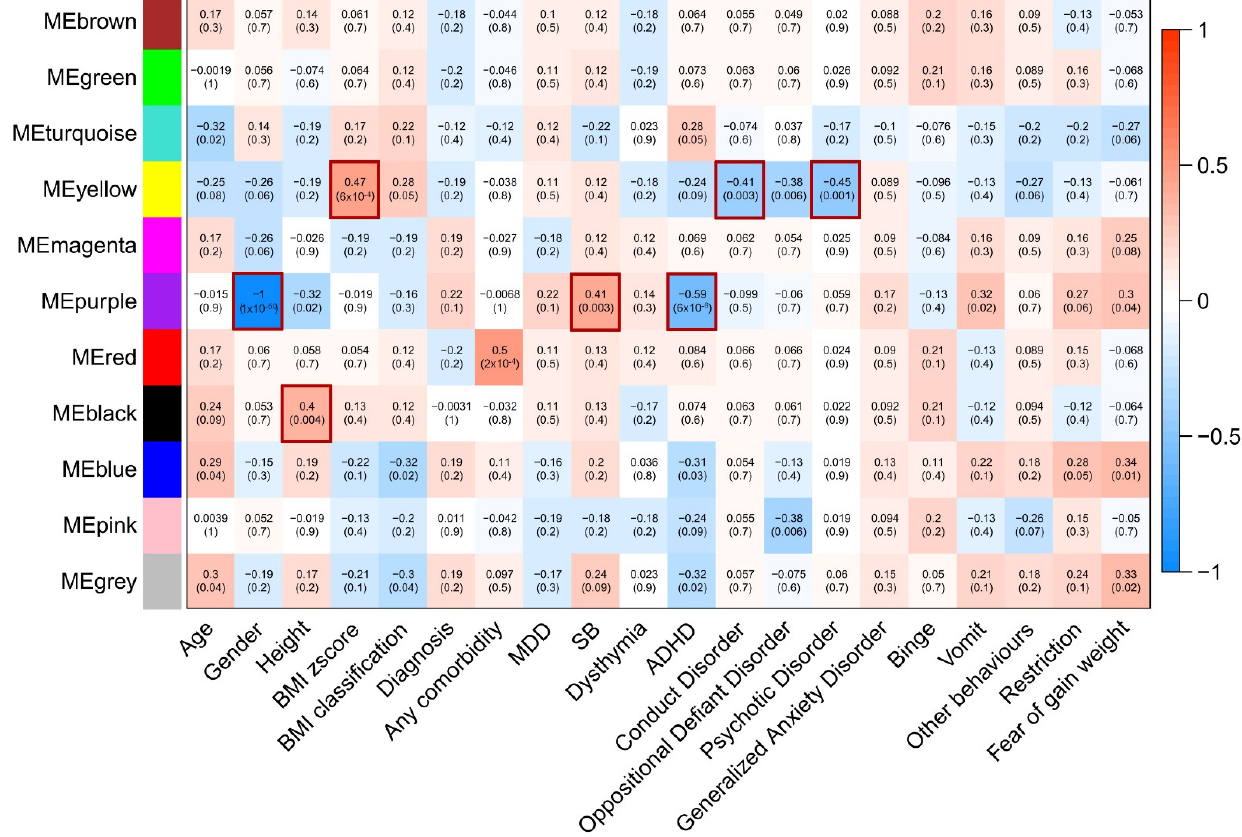
Figure 1. Correlations between modules and clinical features. MDD: major depressive disorder. SB: suicidal behavior. ADHD: attention deficit hyperactivity disorder. Red borders indicate significant correlations. Significance indicates p -values < 5 × 10 − 3